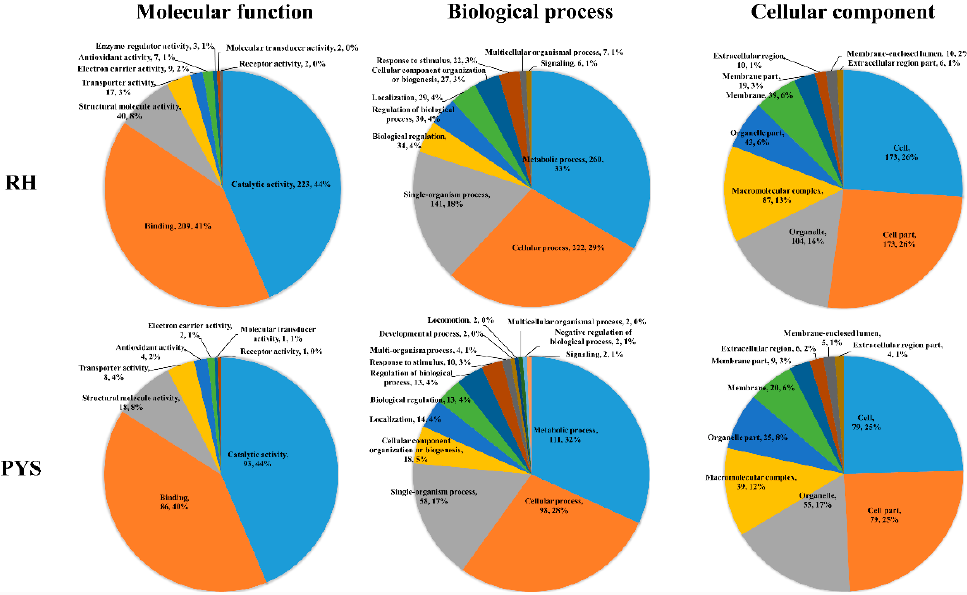
Figure 3. Gene Ontology (GO) enrichment analysis of the acetylated proteins in RH and PYS strains. Functional classification of acetylated proteins in each strain according to the categories of molecular function, biological process, and cellular component. The numbers of DAPs and percentages of DAPs in relation to the total acetylated proteins involved in specific GO terms are shown.